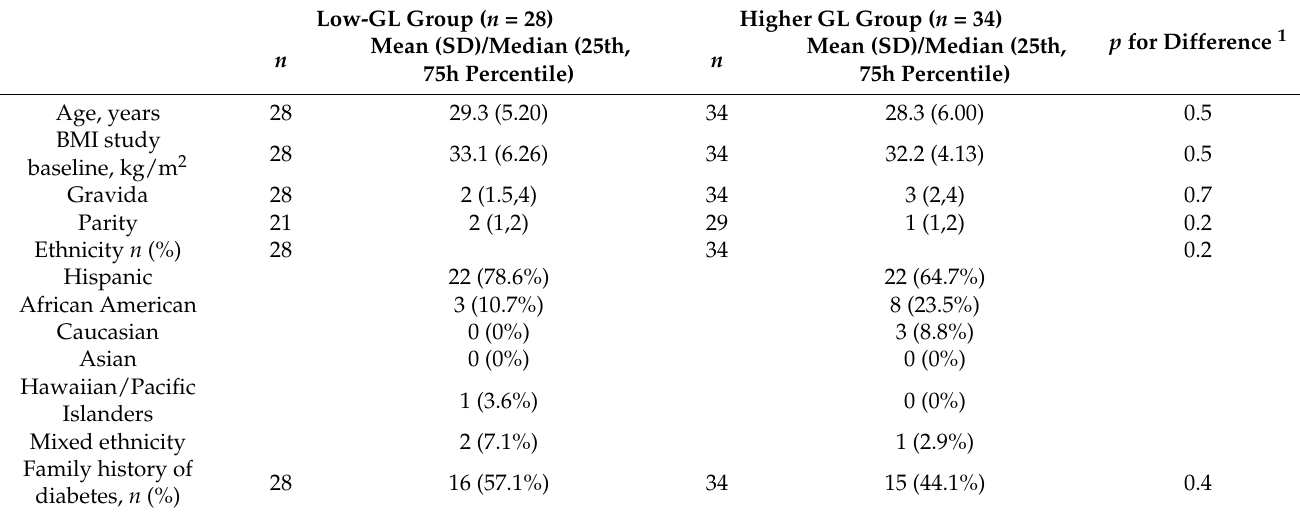
Table 1. Participant characteristics by intervention